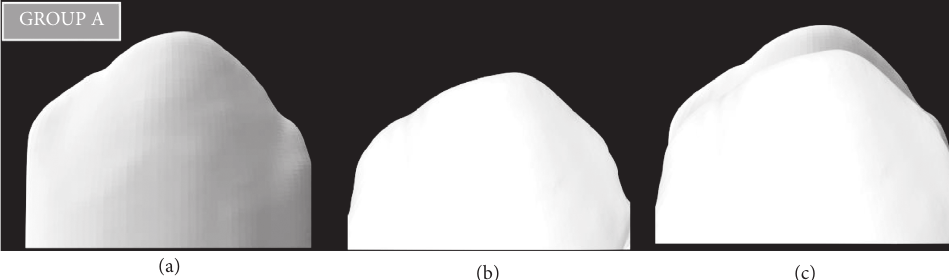
Figure 2: (a) 3D prescan of primary teeth with Group A, (b) 3D postscan of primary teeth with Group A, and (c) superimpose of prescan and postscan with Group